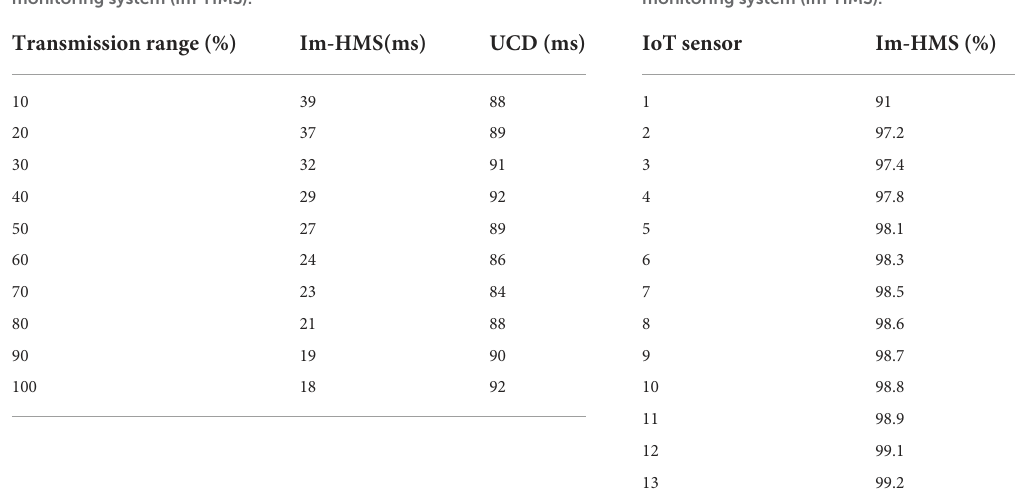
TABLE 3 Efficiency analysis of the proposed intelligent mobile health monitoring system